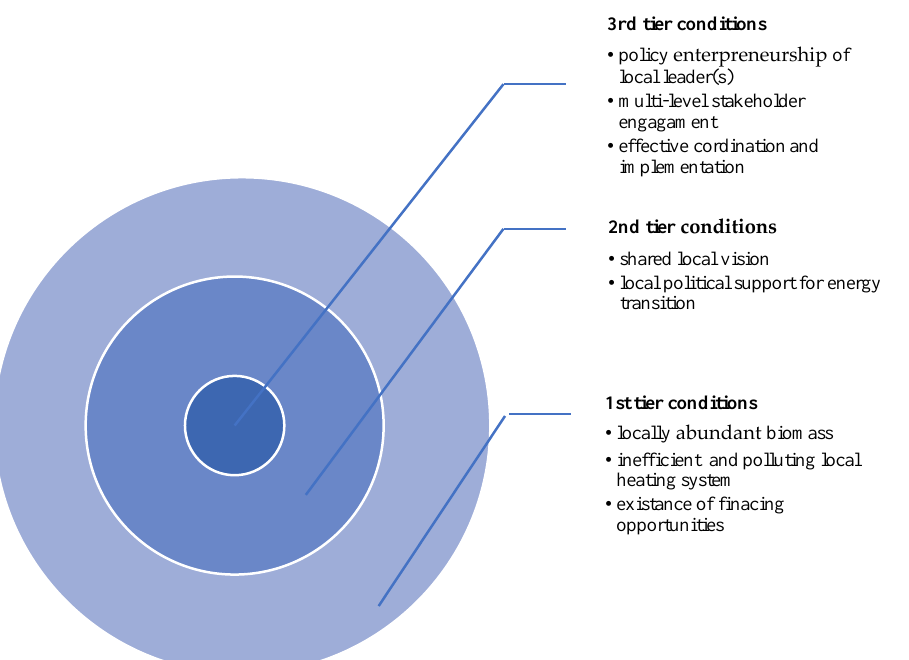
Figure 10. Summary of the sets of critical conditions for the outcome found in the case of the mu- nicipality of Priboj.